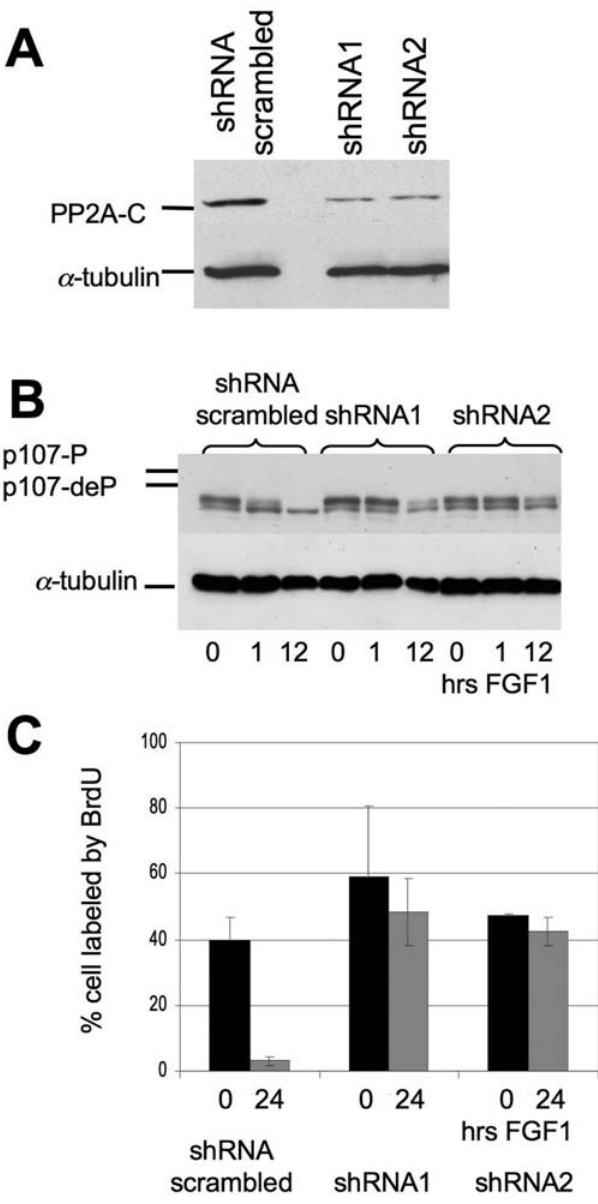
Figure 4. Knockdown of PP2A catalytic subunit inhibits FGF- induced p107 dephosphorylation. RCS cells were infected with retroviruses encoding either 2 different sequences specific for the a - isoform of PP2A-C subunit (shRNA1 and shRNA2) or scrambled shRNA and treated with FGF1. 20 m g of total protein were subjected to SDS- PAGE for inmmunodetection of (A) PP2A-C or (B) p107. (C) Percentage cells labeled by BrdU in the cell lines with knockdown of PP2A-C a upon FGF treatment. Fig. 5A shows that while in untreated cells no association between p107 and PP2A could be detected, immunoprecipitation of PP2A- C from FGF-treated RCS brought down small but significant amounts of P107, most prominent at 1.5 and 3 hrs after FGF addition. As expected, PP2A-A subunits were also detected together with the C-subunits. Consistent with this result antibodies directed against p107 also immunoprecipitated PP2A-A and C subunits from FGF-treated cells but not from untreated cells